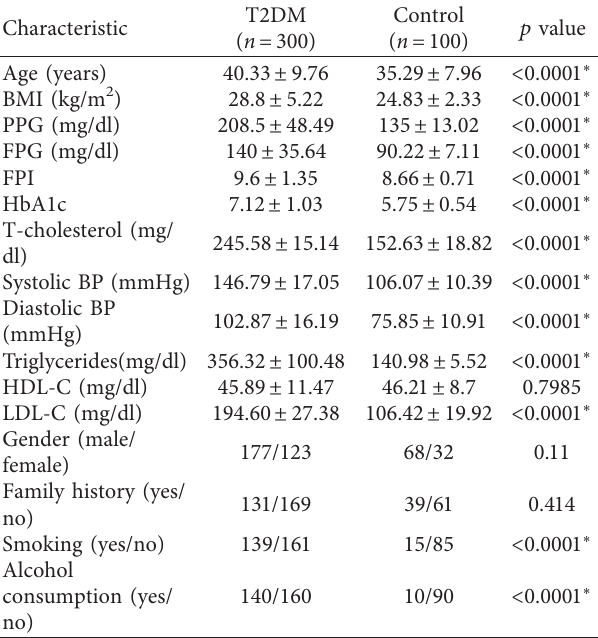
Figure 1: 3% agarose gel electrophoresis for the digested PCR product with Hpy188III (NEB) and Ava I (NEB), respectively. (a) KCNJ11, L- 100bp DNA ladder; W- Homo Wild (A/A); M- Homo Mutant (G/G); H- Hetero (A/G) and (b) KCNQ1, L-100bp DNA ladder; W- Homo Wild (A/A); M- Homo Mutant (C/C); H- Hetero (A/C). Table 1: Clinicopathological characteristics of T2DM patients and